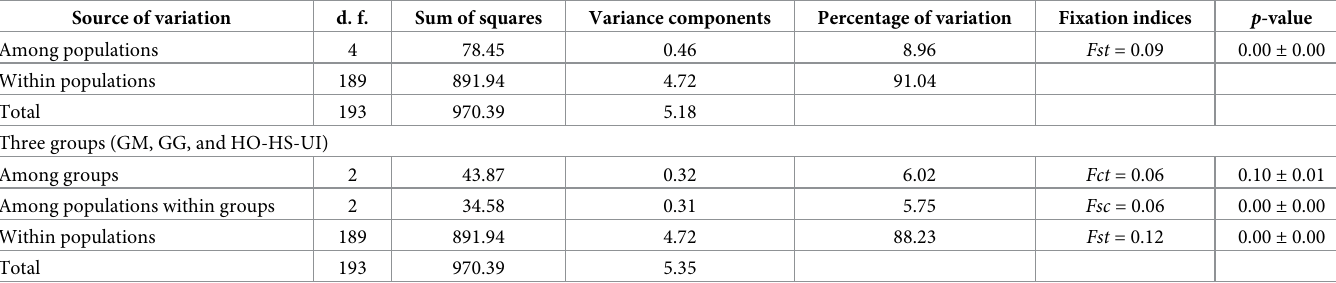
The AMOVA analysis with all populations set as one group (Table 3) revealed that the genetic variation within the population (91.04%) is higher than variation among populations (8.96%). The result of AMOVA using three groups (GM, GG, and HO-HS-UI) defined by UPGMA and DAPC analyses revealed the most genetic variation was attributed to differences within populations (88.23%). Genetic differences among populations and among populations within groups respectively accounted for 6.02% and 5.75% of genetic variation (Table 3). As shown in Fig 3, S . polylepis individuals formed three groups according to DAPC analysis. The scatterplot Table 3. AMOVA results for 97 Saussurea polylepis individuals among and within populations. Source of variation d. f. Sum of squares Variance components Percentage of variation Fixation indices p -value Among